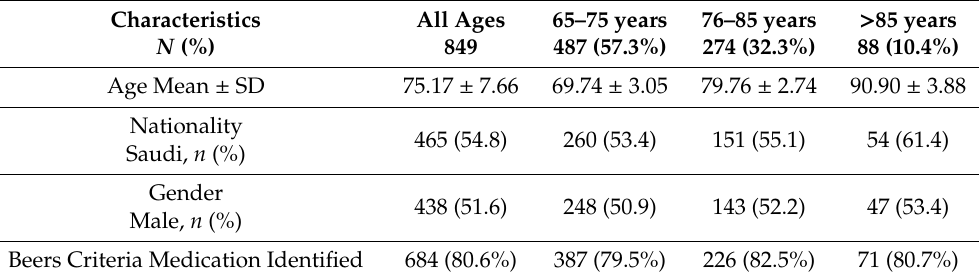
Figure 1. Flow of patients throughout the study. Table 1. General characteristics of the patients included in the study.